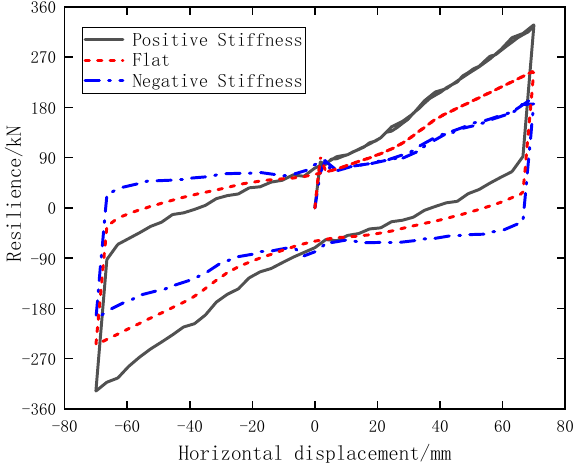
Figure 16. Hysteresis curve of SMA positive stiffness, flat, negative stiffness shock absorber.